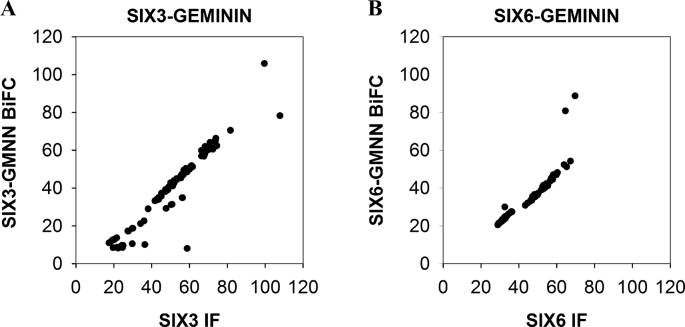
Single-cell analysis of SIX3/SIX6 and Geminin-cotransfected COS-1 cells. Mean pixel intensities for the SIX3/SIX6-GEMININ BiFC signals are plotted against the SIX3/SIX6 immunofluorescence (IF) intensities for ~100 cells. A) SIX3-GEMININ complex formation. B) SIX6-GEMININ complex formation